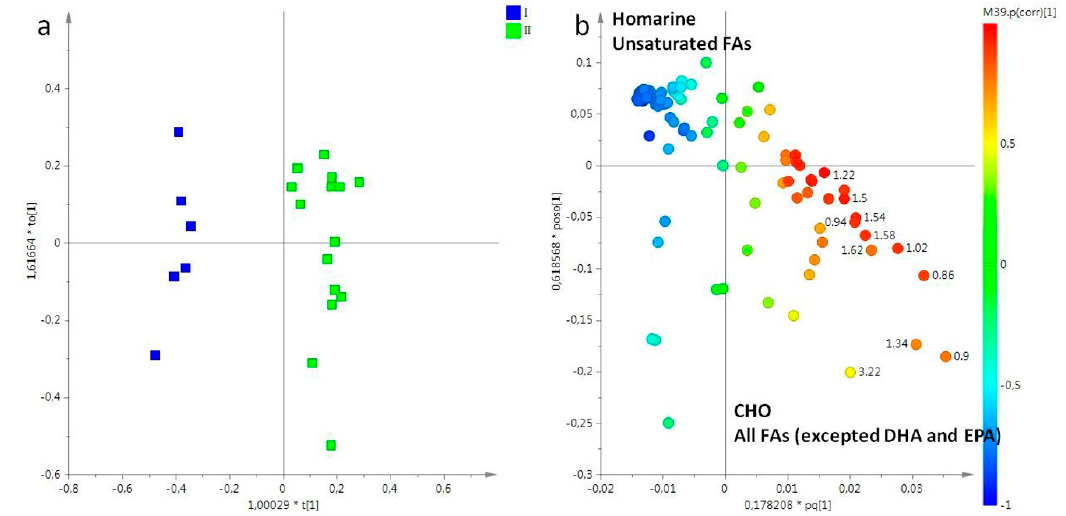
Figure 5. ( a ) OPLS-DA t[1] / t[2] scores plot of for lipid extracts of tentacles of R. pulmo collected in different sampling periods: blue box, March sampling (I); green box, May sampling (II). ( b ) Loading plot for the model; the variables indicated ppm in the 1 H NMR spectrum.